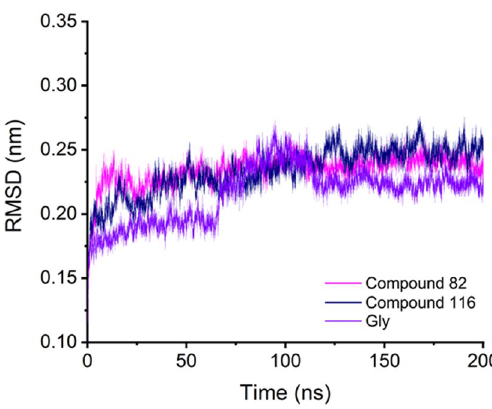
Figure 8. RMSD of GO during the 200 ns